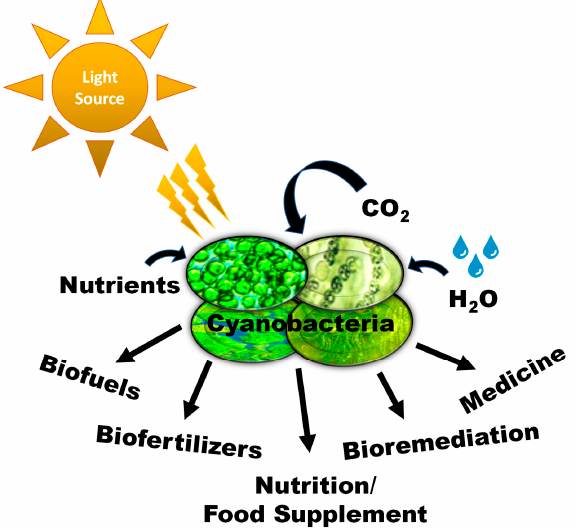
Figure 1. Overview of the potential of cyanobacteria in different fields of science and development.